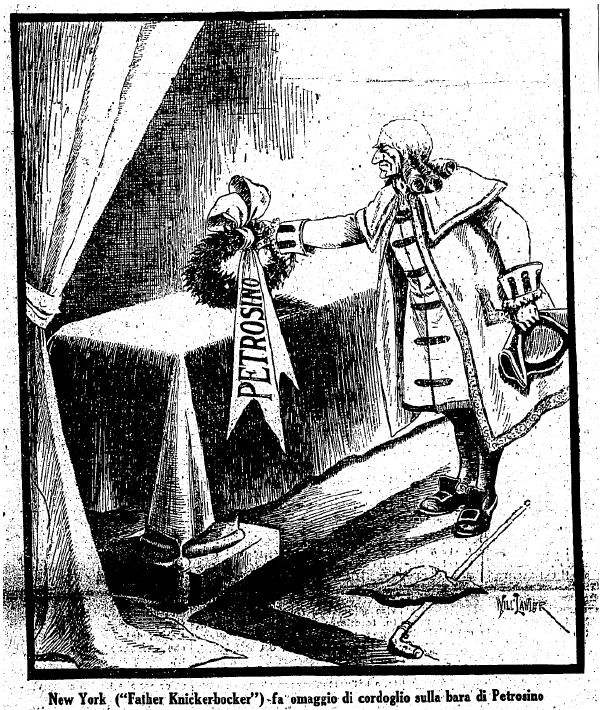
Figure 2. Il Progresso Italo-americano , 13 April 1909, p. 1.